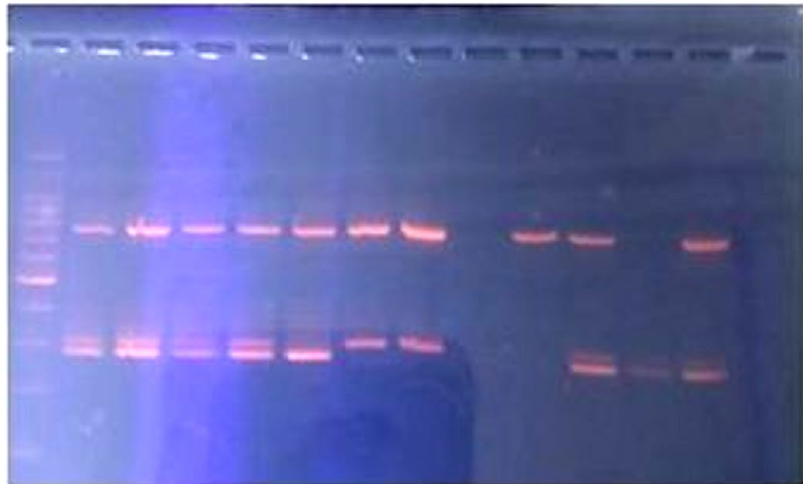
Fig. 6. In this PCR image from (left to right), lane 1 is the 100bp DNA ladder, lane 2 is positive control, lane 3 to 8 are mecA gene positive, lane 9 is negative sample, lane 10 is mecA gene negative, lane 11 to 13 is mecA gene positive and lane 14 is negative control